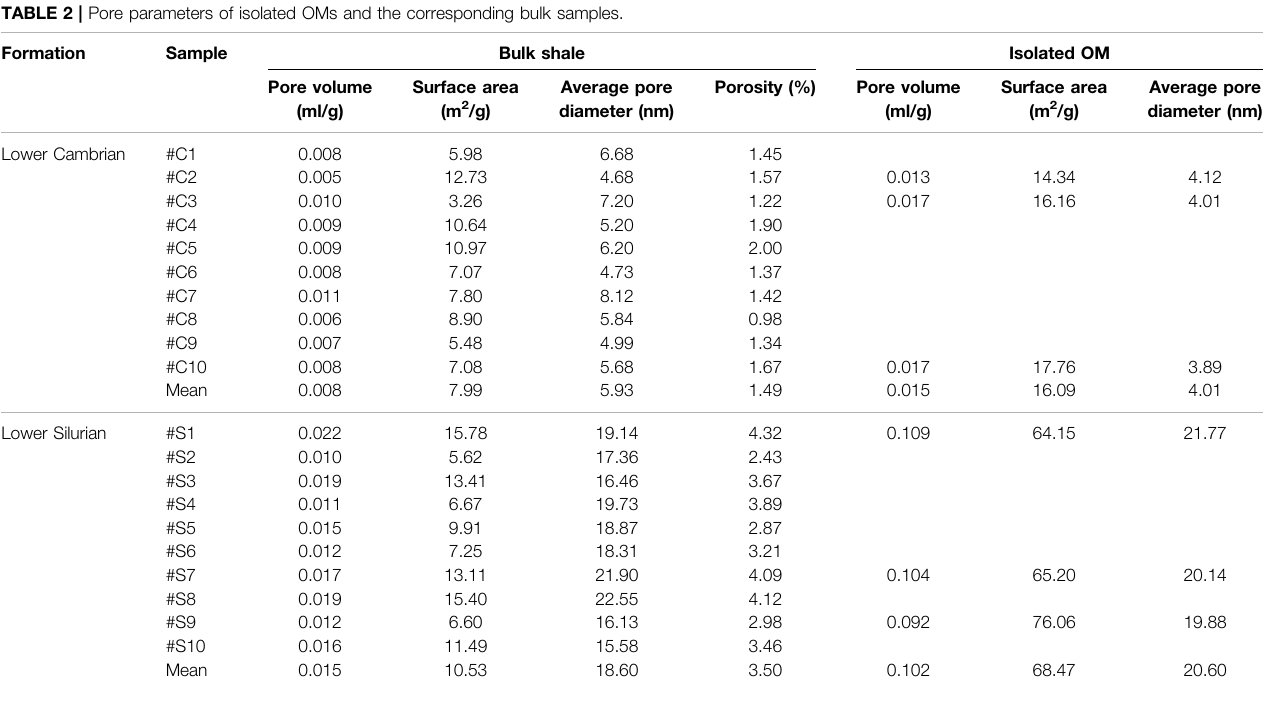
TABLE 2 | Pore parameters of isolated OMs and the corresponding bulk